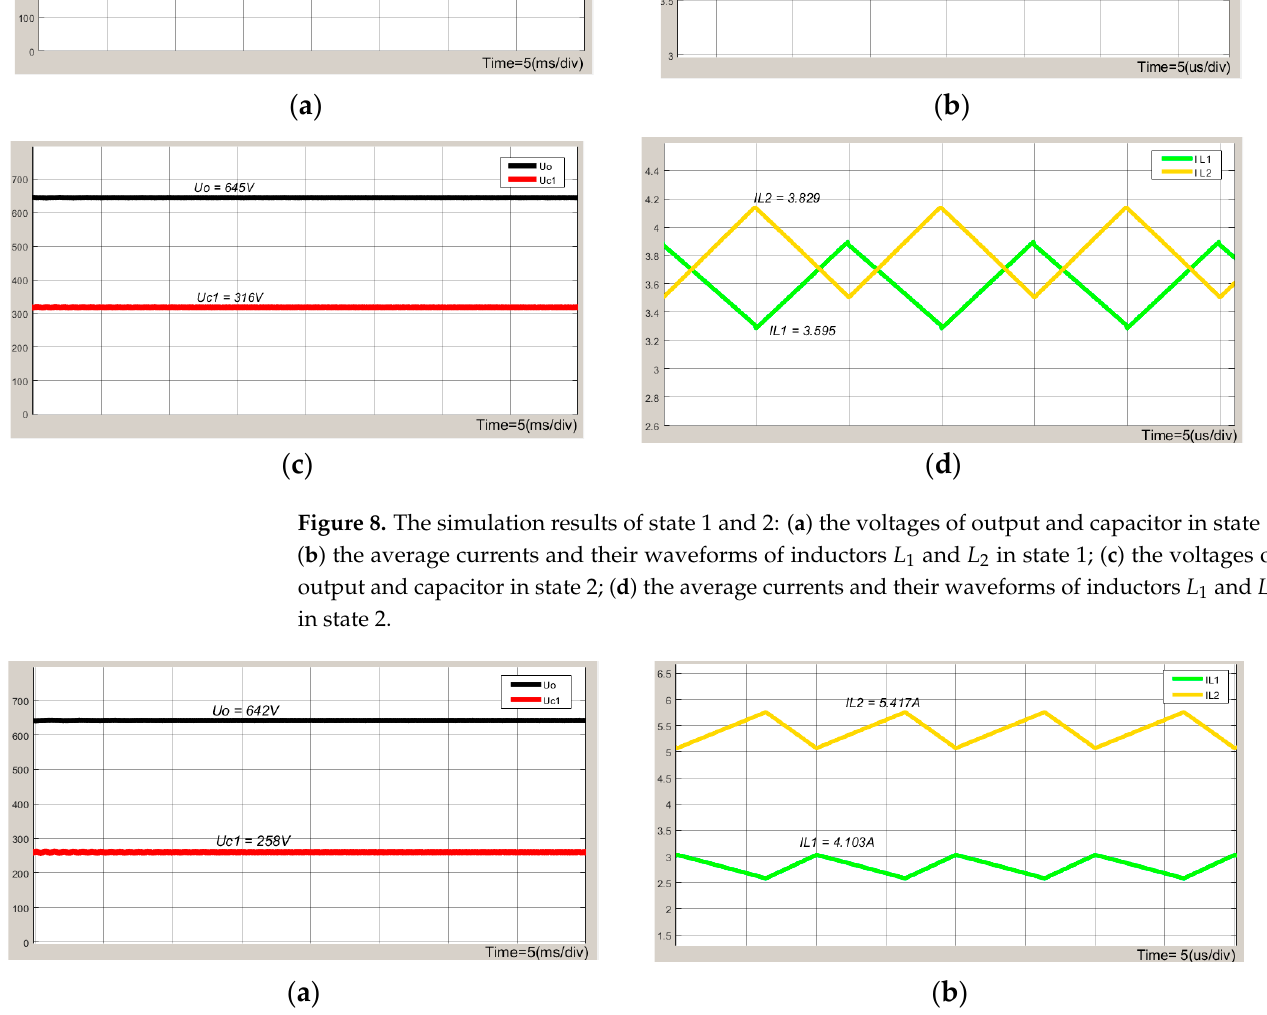
Figure 9. The simulation results of state 3: ( a ) the voltages of output and capacitor in state 3; ( b ) the average currents and their waveforms of inductors L 1 and L 2 in state 3.